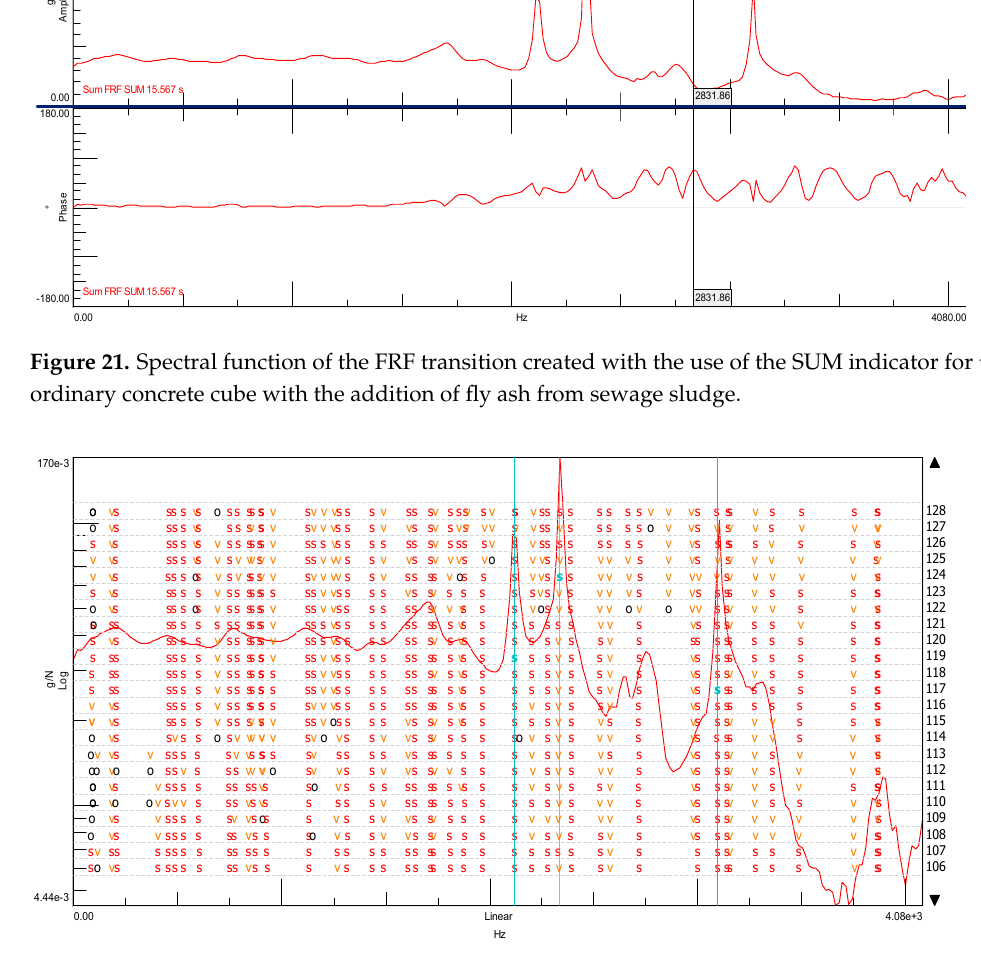
Figure 22. Stabilization diagram made of the spectral transition function FRF (using the SUM index) for the ordinary concrete cube with the 20% addition of fly ash from sewage sludge. (s—stable frequency field, v—modal vector, o—empty field).